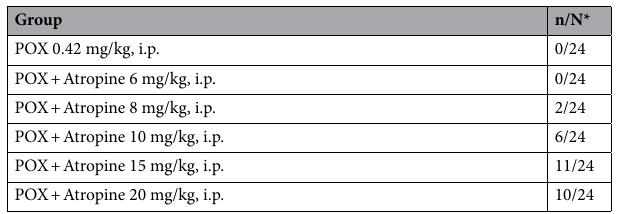
Group n/N* POX 0.42 mg/kg, i.p. 0/24 POX + methoctramine 3 mg/kg, i.p. 2/24 POX + methoctramine 4 mg/kg, i.p. 4/24 POX + methoctramine 6 mg/kg, i.p. 7/24 POX + methoctramine 8 mg/kg, i.p. POX + methoctramine 10 mg/kg, Table 2. Selection of methoctramine dose for antidotal therapy of mice poisoned by 2xLD 50 of POX. * n number of mice survival 120 h after POX poisoning. N total number of mice in the group. POX—0.42 mg/kg, i.p.